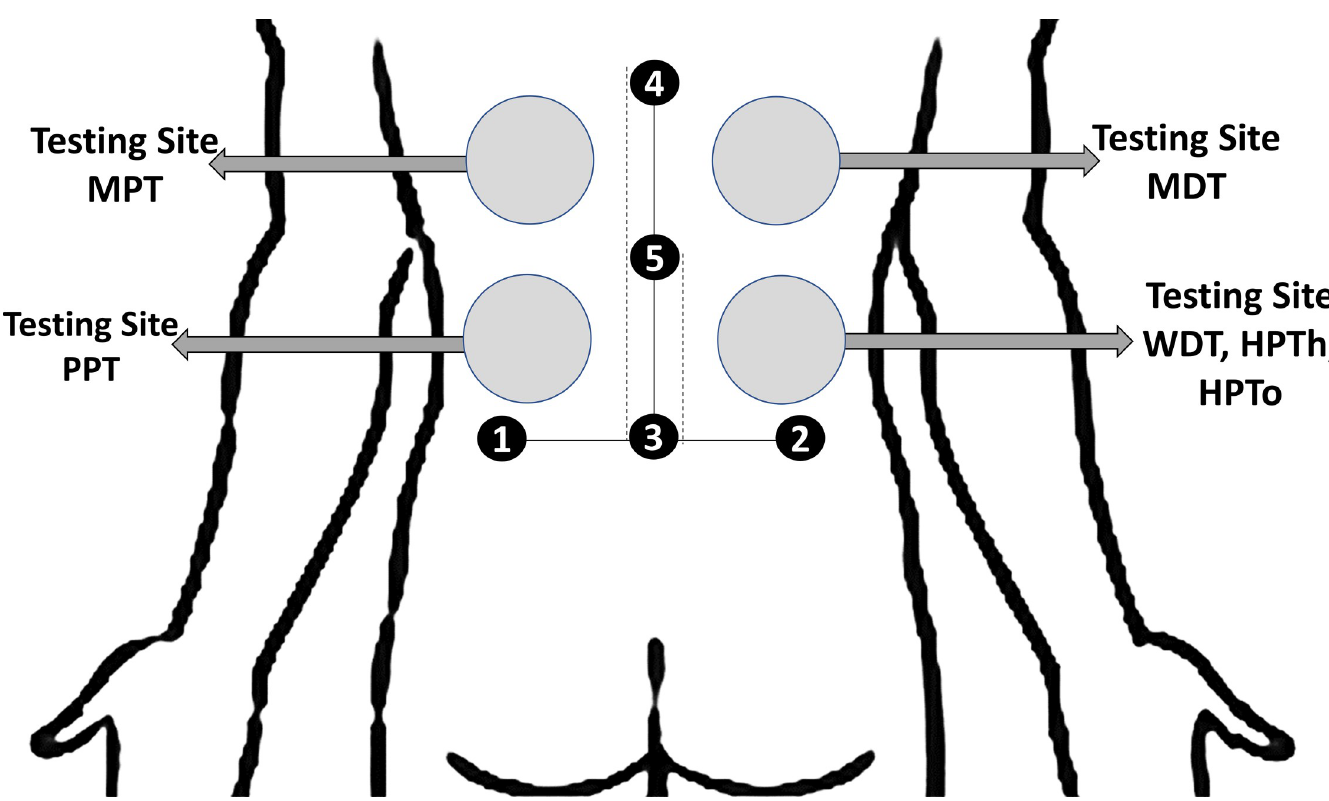
Fig 2. Figure showing sites in the lower back marked for QST measurements and reference points for the application of taping interventions. Points 1 and 2 = superior aspect of left and right iliac crests, respectively; point 3 = L4-5 vertebrae corresponding to the horizontal intercristal line connecting points 1 and 2; point 4 = mid-thoracic spine approximately 30 cm vertically above the point 3; and point 5 midway between points 3 and 4. MPT, mechanical pain threshold; MDT, mechanical detection threshold; PPT, pressure pain threshold; WDT, warm detection threshold; HPTh, heat pain threshold; HPTo, heat pain